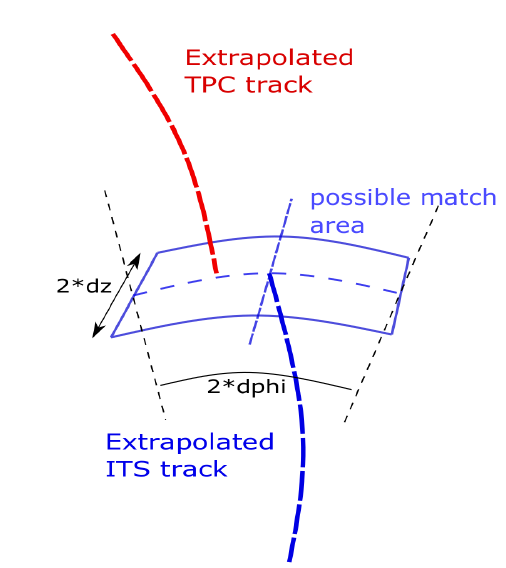
Figure 5. TPC and ITS track matching